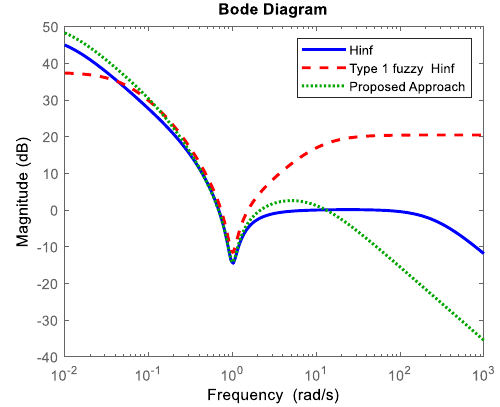
Figure 15. Comparison of alternative controllers.